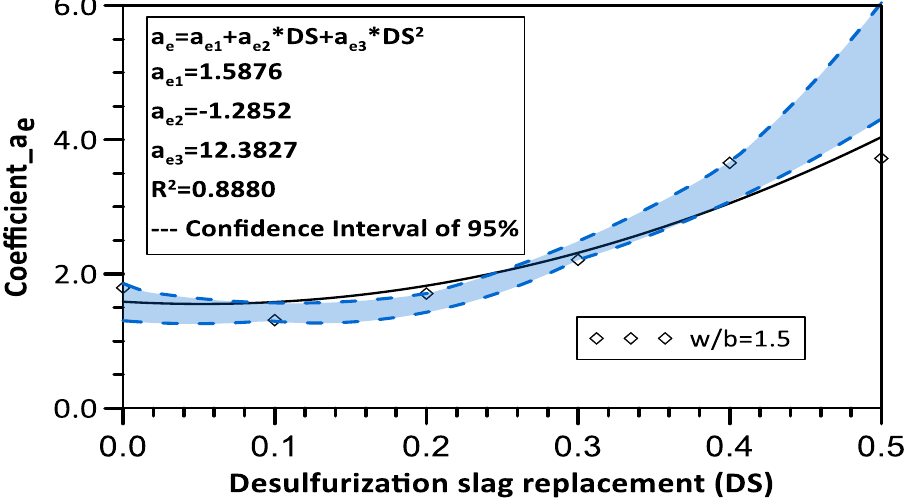
Figure 12. Characteristics of the coefficient 𝑎 𝑒 of the surface resistivity prediction model versus the DS content.